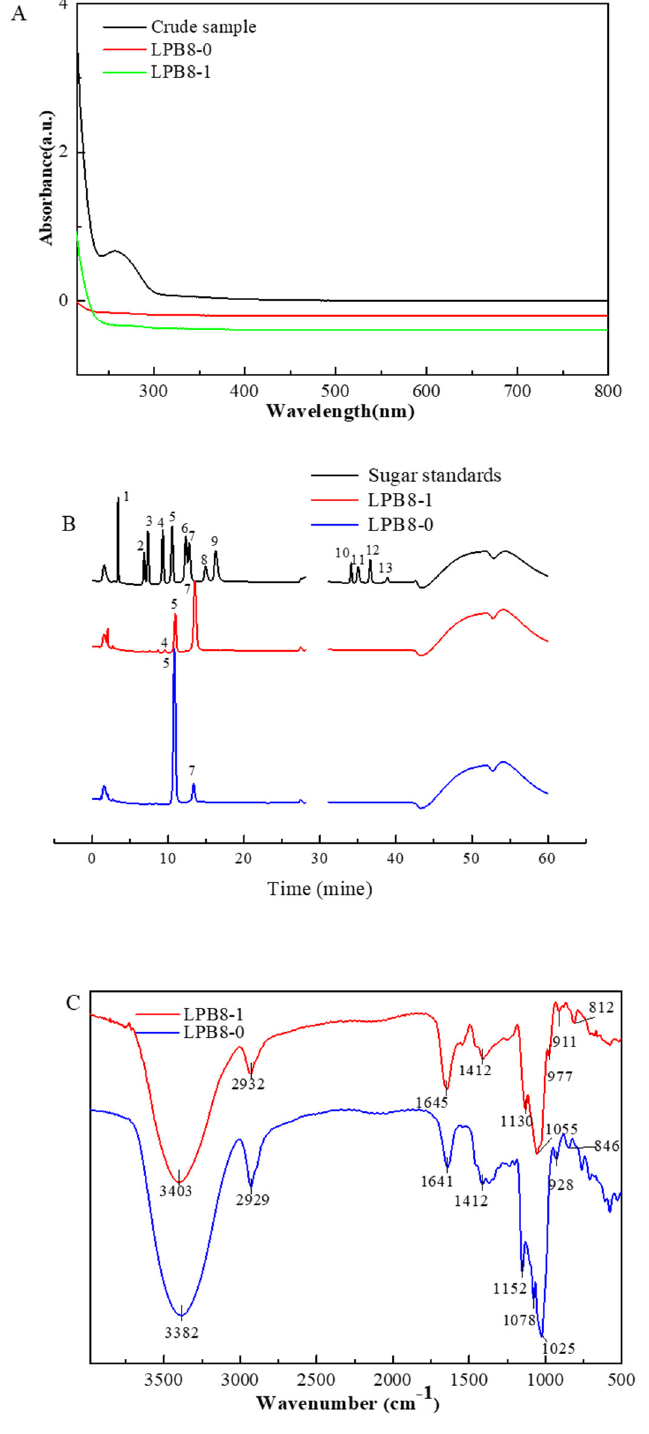
Figure 2. ( A ) UV − vis absorption spectra of crude EPS (black curve), LPB8-0 (red curve), and LPB8-1 (green curve); ( B ) HPAEC-PAD profiles of monosaccharide standards (black curve, peak identities: 1, fucose; 2, rhamnose; 3, arabinose; 4, galactose; 5, glucose; 6, xylose; 7, mannose; 8, fructose; 9, ribose; 10, galacturonic acid; 11, guluronic acid; 12, glucuronic acid; 13, mannuronic acid), LPB8-0 (blue curve) and LPB8-1 (red curve); ( C ) FTIR spectra of LPB8-0 (blue curve) and LPB8-1 (red curve).